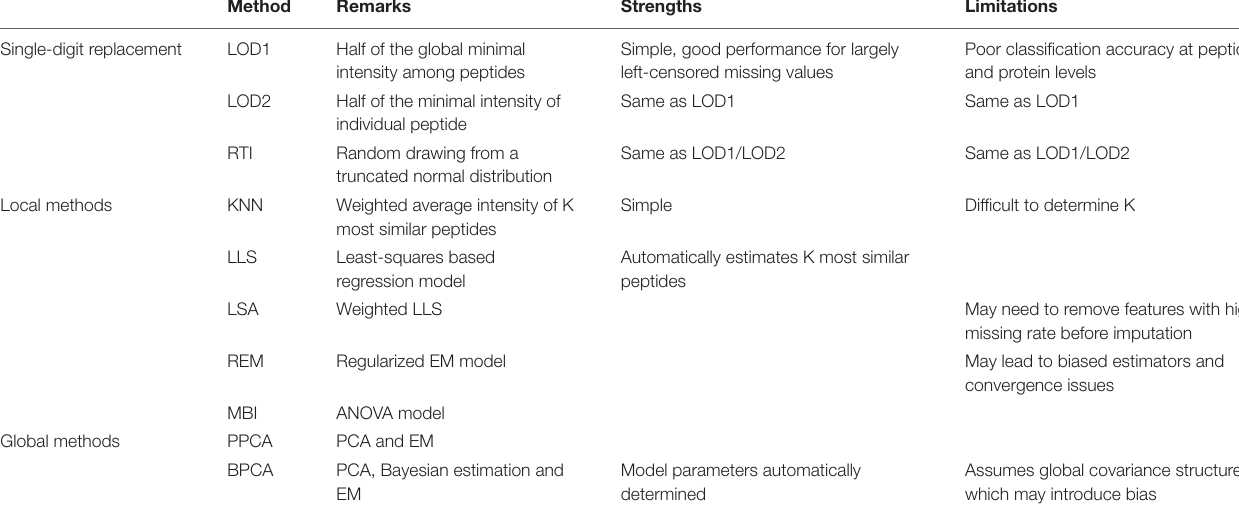
TABLE 4 | Proteomic data imputation